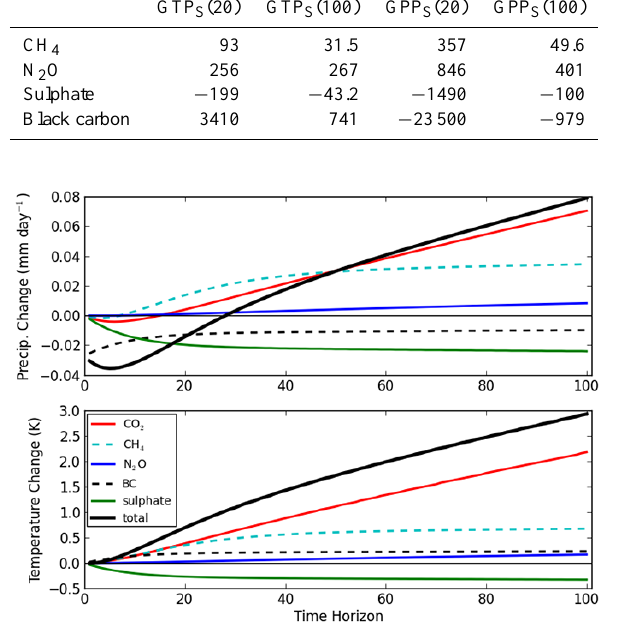
Figure 8. Precipitation change, in mmday − 1 (top panel), and tem- perature change, in K, (bottom panel) in the years after 2008, assuming constant emissions at 2008 levels, calculated using the AGPP S and AGTP S and using estimated emissions of the species in